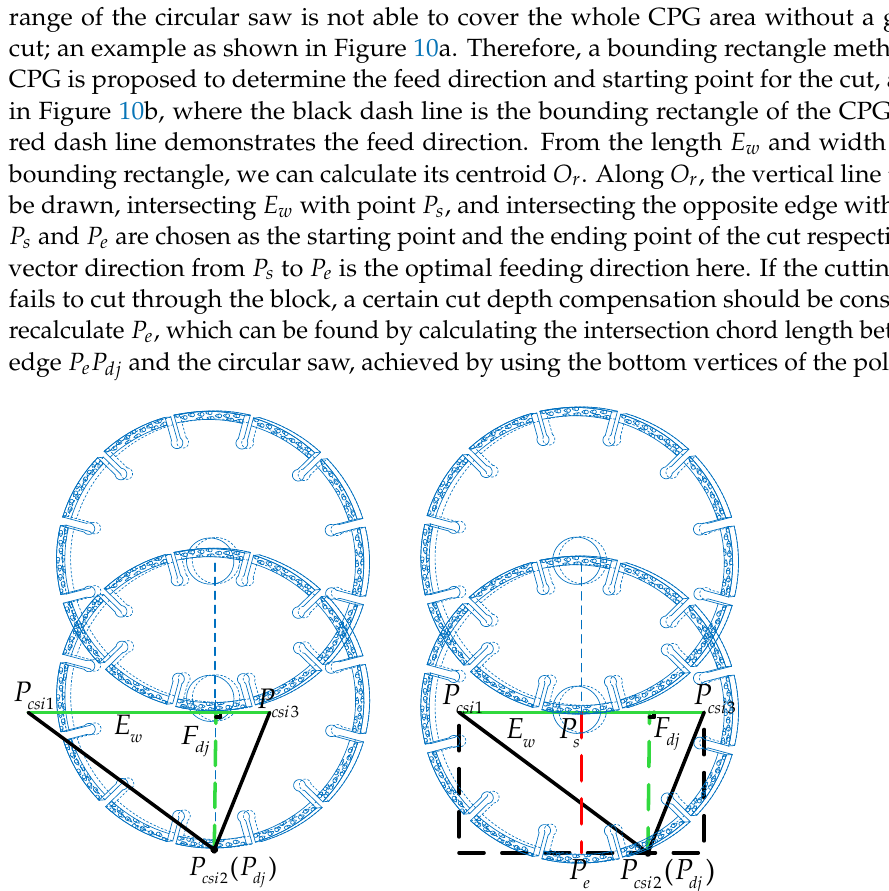
Figure 10. Feed direction of cutting. ( a ) Feed direction along W ; ( b ) feed direction along